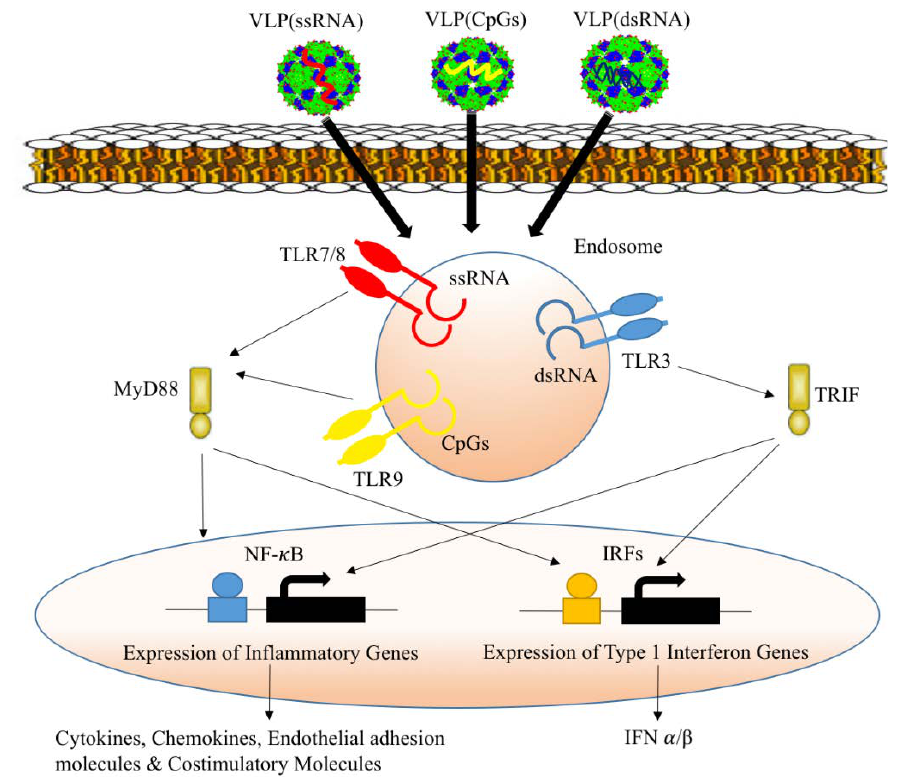
Figure 4. Packaging VLPs with innate immune-modulators. Viral capsid-derived VLPs packaging different nucleic acids can be efficiently internalized by APCs. The packaged nucleic acids will be released in the endosomal compartment of the cell following degradation of VLP-protein shell.